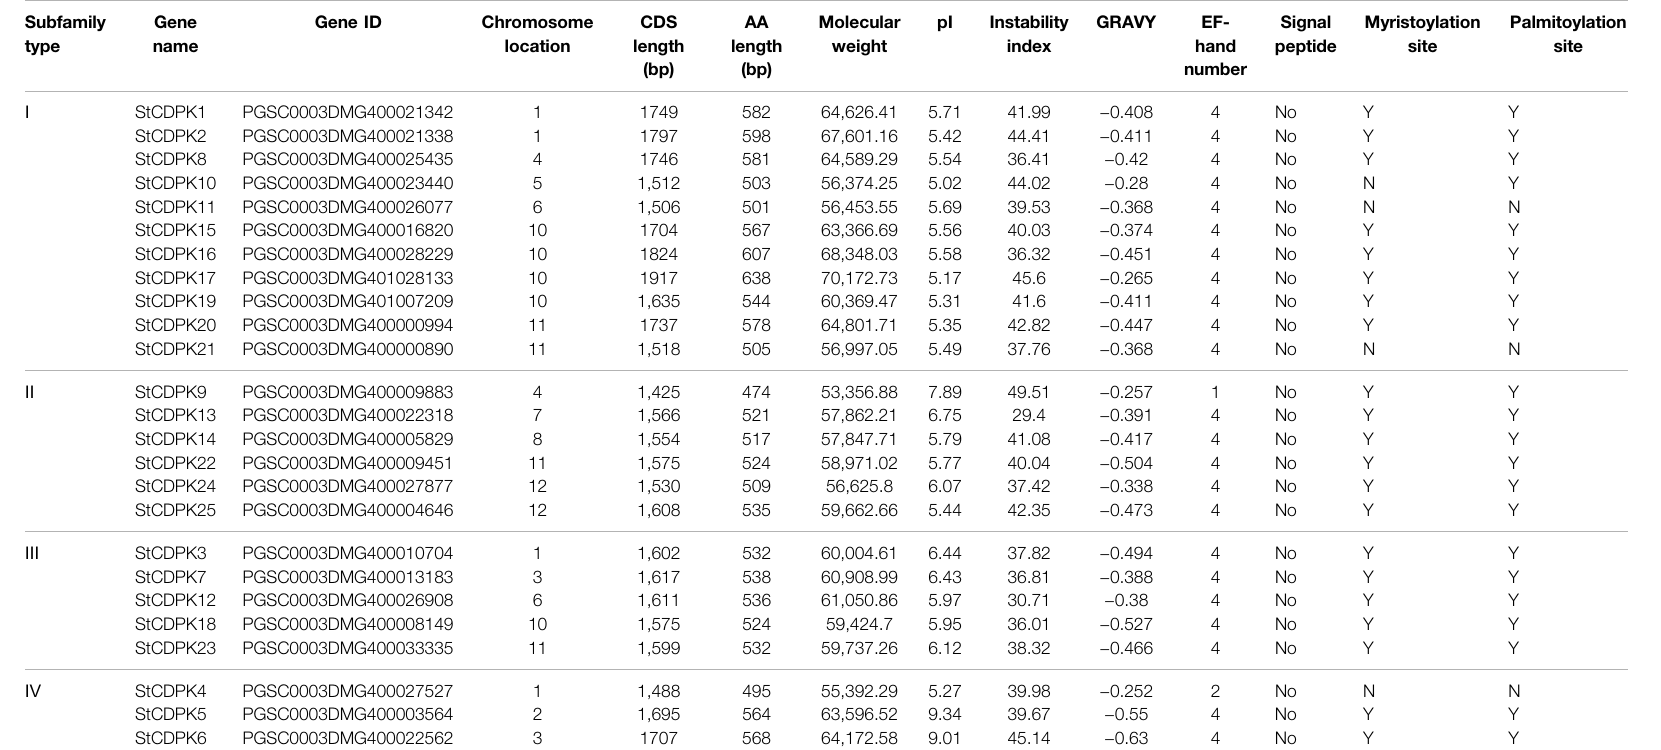
TABLE 1 | The basic characteristics and Physico-chemical properties of CDPK gene family members in